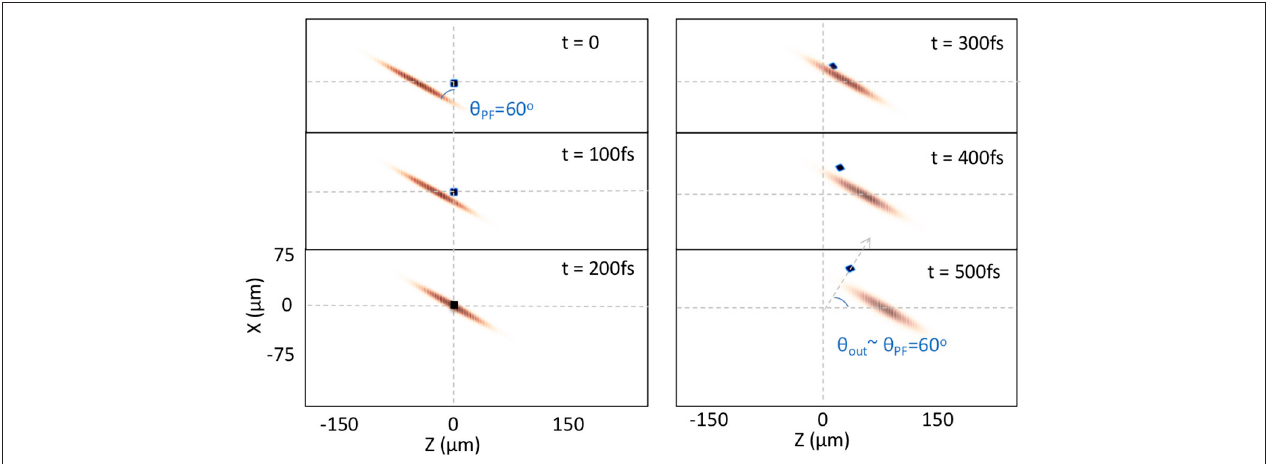
FIGURE 1 | Calculation in the lab frame from the OSIRIS 4.0 PIC code for a 20 fs pulse duration, 60 ◦ PFT angle, and 200 keV peak ponderomotive potential. The red shows the intensity distribution for the tilted pulse fronts. The blue-black dots represent the location of the electron bunch [2.5 µ m square, initial position ( X 0 , Z 0 ) = (0,0)]. Here the focal plane is at Z = − 20 µ m . The horizontal dashed lines represent the optical axis for each of the frames. The arrow at t = 500 fs represents the direction of the accelerated bunch, which is close to the normal of the pulse